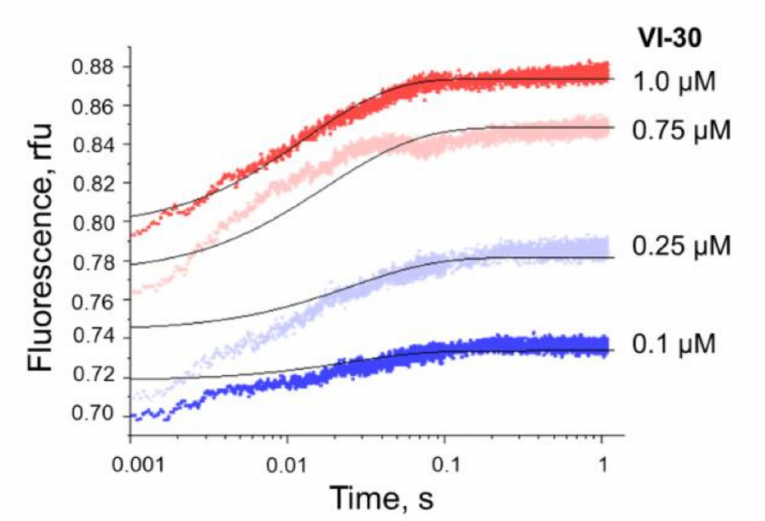
Figure 4. Kinetic curves for the interaction of Nt.BspD6I (1 µ M) with DNA duplex VI-30 , which contains the enzyme’s recognition site. The measurements were performed in the absence of divalent metal ions; duplex concentrations are shown next to the curves. Coloured dots indicate experimental data, and solid curves denote calculated kinetic curves corresponding to Scheme 1, which contains one reversible stage of complex